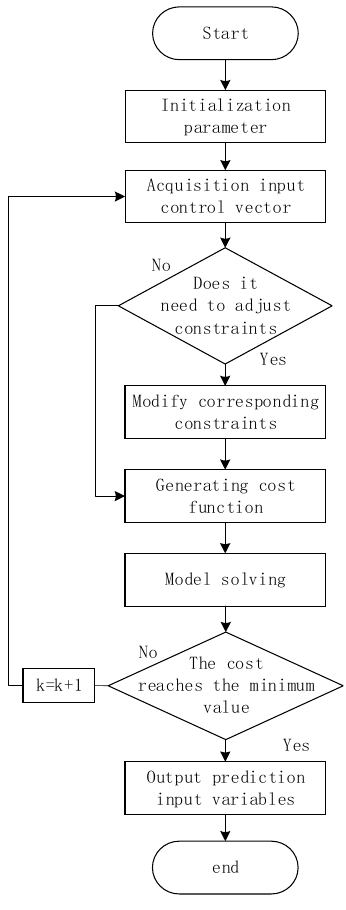
Figure 2. MPC algorithm control flowchart.